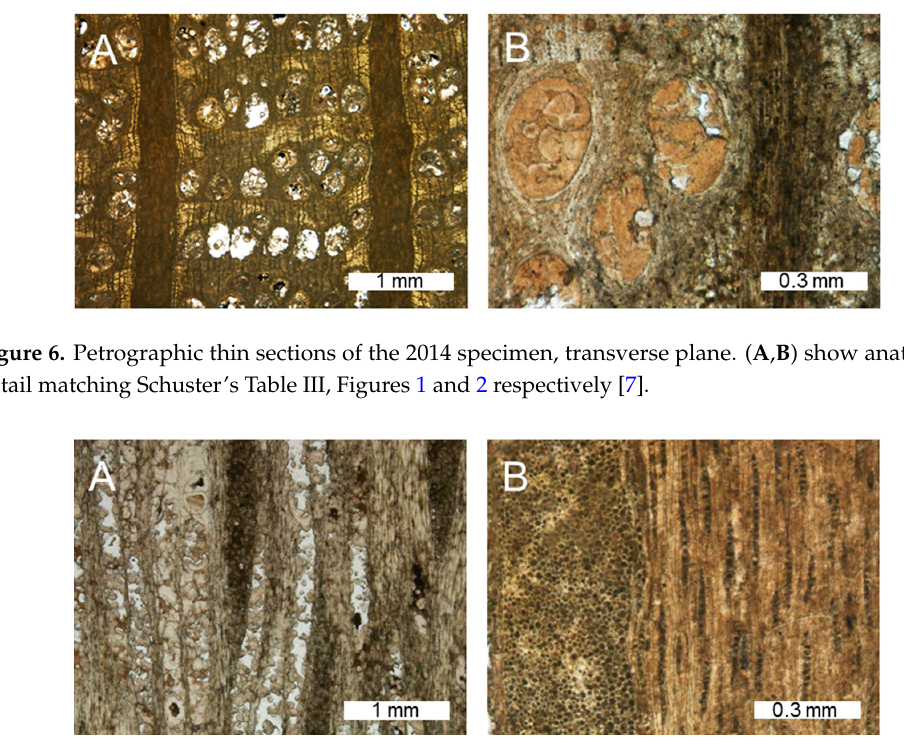
Figure 9. SEM SE images showing the external morphologies of petrified cells. ( A ) Radial view of tracheids and ray cells; ( B ) silicification of intracellular spaces results in relatively smooth vitreous fracture surfaces, with areas of incomplete silicification revealing the morphologies of individual tracheids; ( C ) individual cell walls mineralized with tabular opal-CT microcrystals.